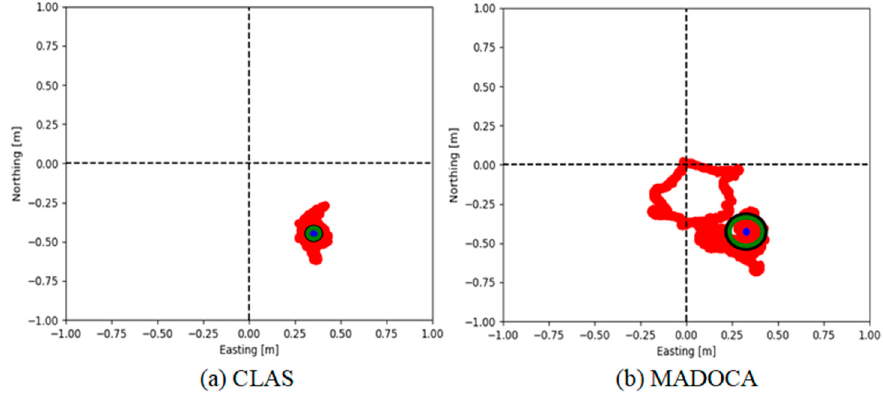
Figure 6. Static positioning experiment results: ( a ) CLAS, ( b ) MADOCA; the red points are the position points, the blue points are the mean of the position points, the measurements within the circles in black are the 2DRMS, the radius of the circles in green are the CEP. The CLAS position points are scattered over an area about 0.25 m by 0.50 m and they are uniformly grouped inside this area shown in Figure 6a. The sudden oscillations or instabilities are not too big as shown by the mean position which is centered in the cloud of position points. From Figure 6b, the MADOCA position points are scattered over an area of about 0.70 m by 0.70 m and display a loop inside this area, which accounts for the instability of this positioning augmentation system. However, the mean position is inside the area where the position points are dense, although it is not as good as the CLAS mean position. The 2DRMS and the CEP circles in Figure 6 are smaller for the CLAS in comparison with the MADOCA, which is an expected result caused by the size of the area of the posi- tion points measured. Table 3 list the 2DRMS, the CEP and the average number of satellites Tracked during the test for each one of the receivers. It can be observed that the CLAS positioning aug- mentation system has a reasonably small 2DRMS and CEP; although they are around four times bigger than the RTK results, they are still less than 0.05 m. In the other hand, the MADOCA positioning augmentation system displays 2DRMS and CEP about 10 times bigger than the RTK. Table 3. Accuracy analysis. Positioning Augmentation System